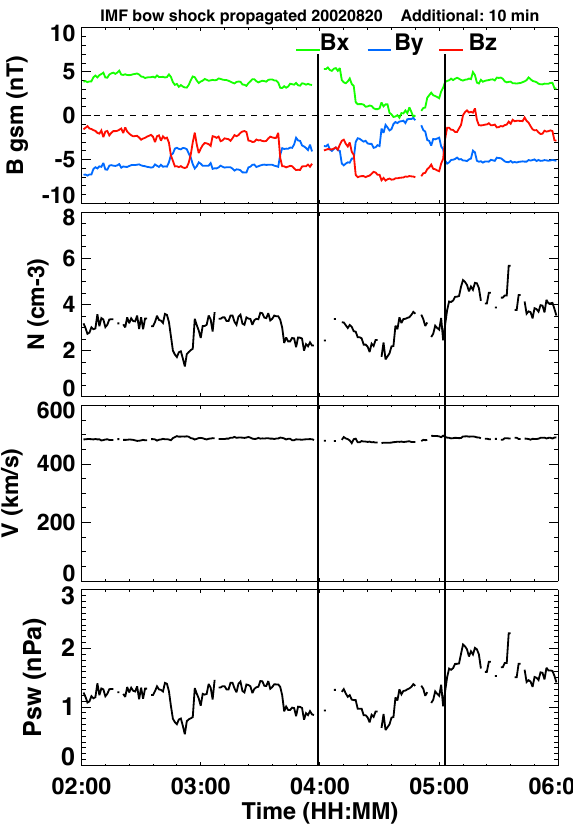
Fig. 1. Interplanetary magnetic field on 20 August 2002 propagated to the bow shock (omniweb), to which an additional 10min has been added for the propagation from the bow shock to the mid-altitude cusp. Top panel shows the three components of the IMF in GSM coordinate system. The 2nd panel from the top shows the solar wind density, and the 3rd panel from the top the solar wind speed. Bottom panel shows the solar wind dynamic pressure. Vertical lines mark the interval when the cusp was crossed by the Cluster spacecraft.